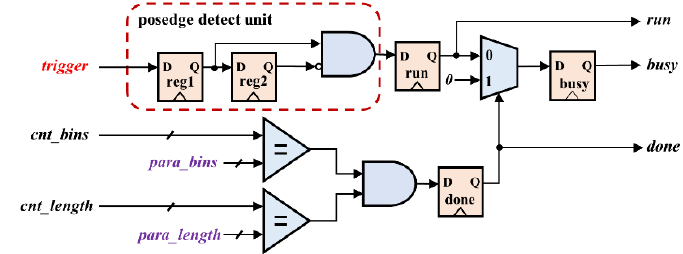
Figure 5. The control module logic structure diagram.